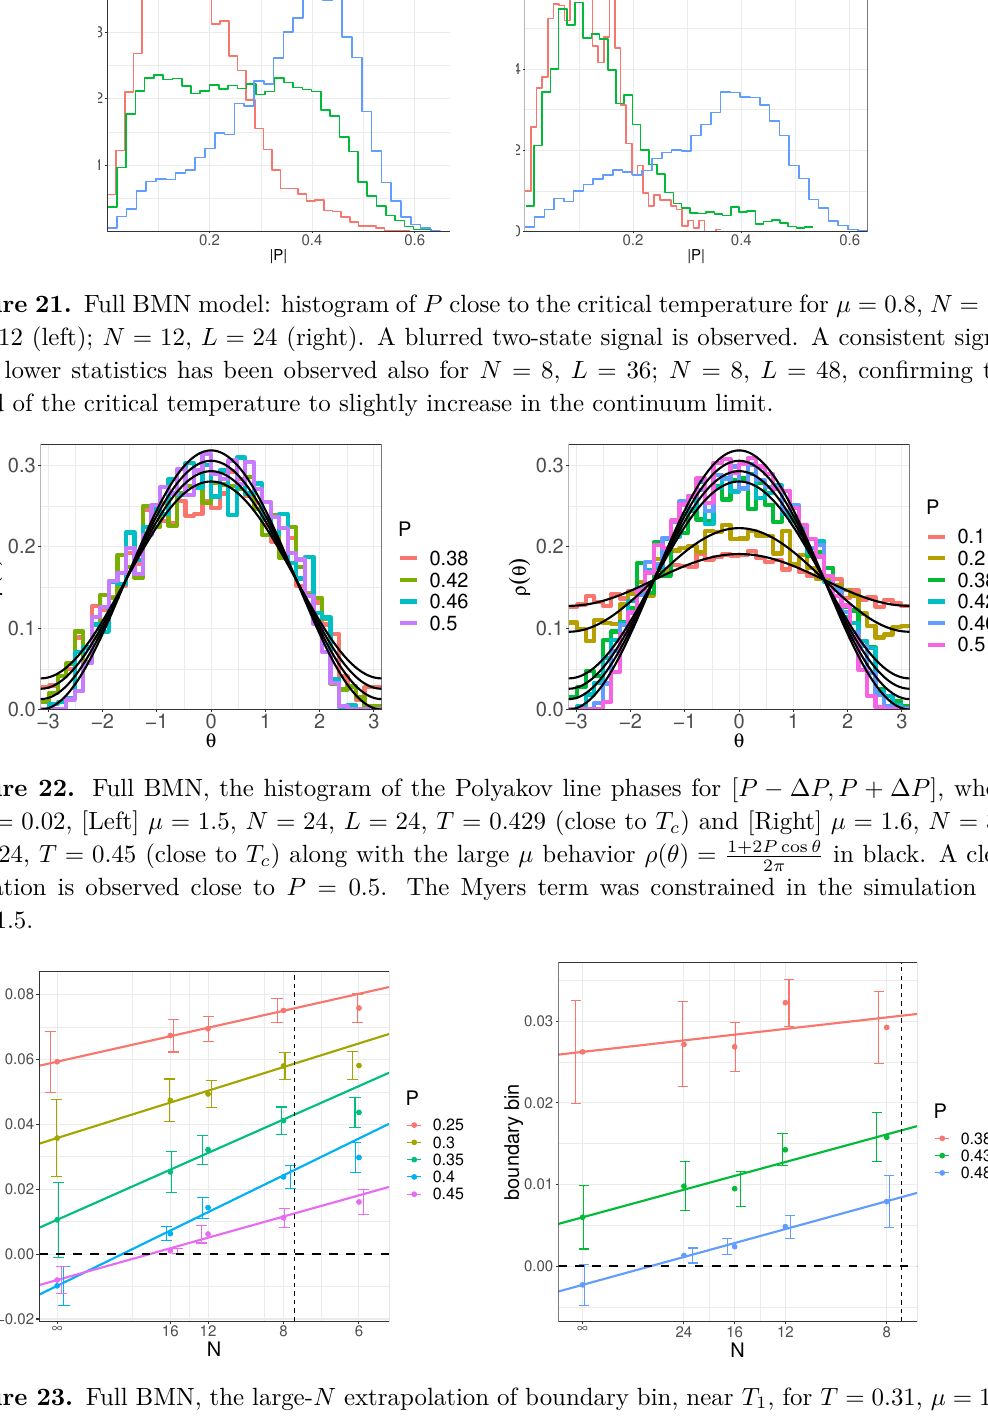
Figure 23. Full BMN, the large- N extrapolation of boundary bin, near T 1 , for T = 0 . 31 , µ = 1 . 0 , L = 12 (left) and T = 0 . 429 , µ = 1 . 5 , L = 24 (right), as well as ∆ P = 0 . 025 . The Myers term is constrained in these